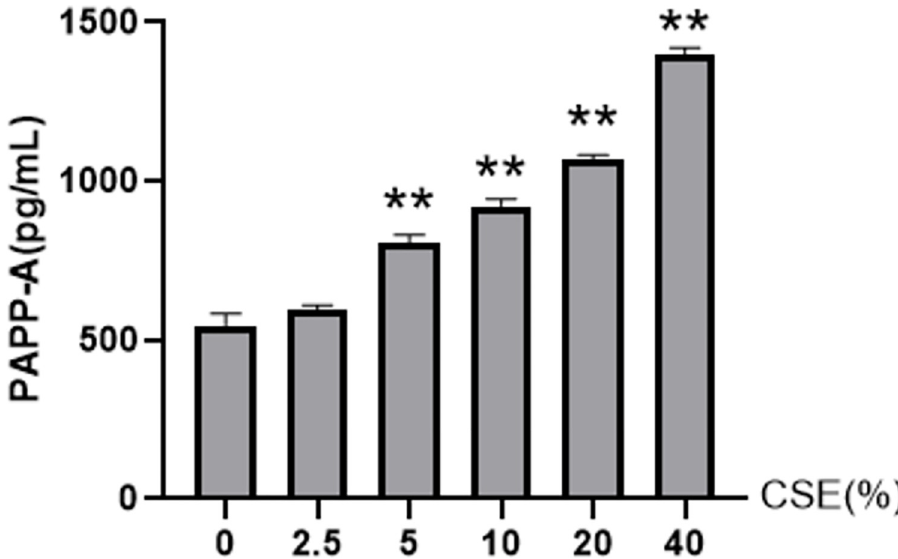
Fig 1. Effect of CSE on PAPP-A secretions in Rat A7r5 cells. A7r5 cells were exposed to different concentrations of CSE and incubated for 8h. PAPP-A secretion was measured in culture supernatants by ELISA. Results are represented as Mean ± S.E.M. �� P < 0.01 vs 0%CSE (n = 5). CSE:cigarette smoke extract; PAPP-A: pregnancy-associated plasma protein